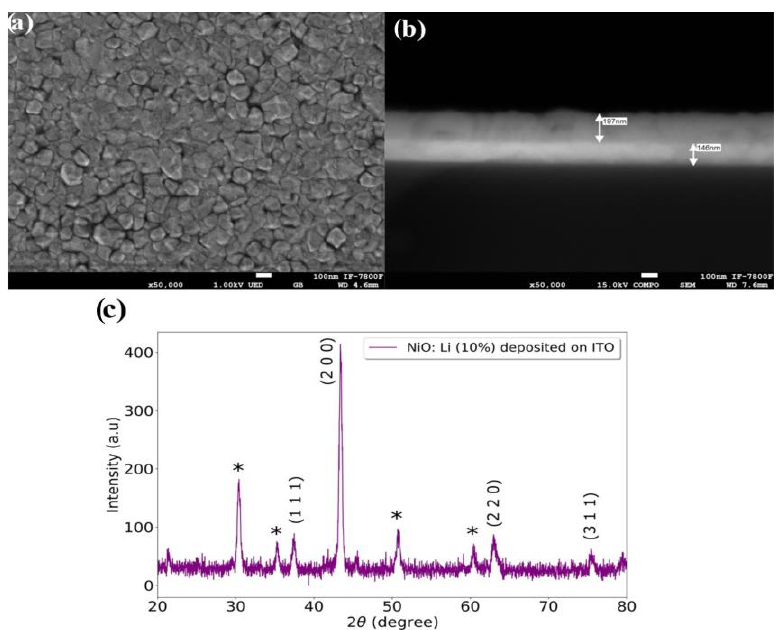
Figure 7. SEM images and XRD pattern of NiO: Li (10%) film deposited on ITO coated glass substrate.